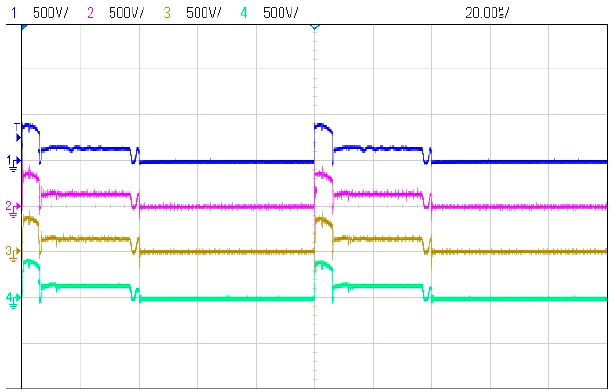
Figure 12. Main IGBT switches collector-emitter voltages (Scale: 500 V / div).